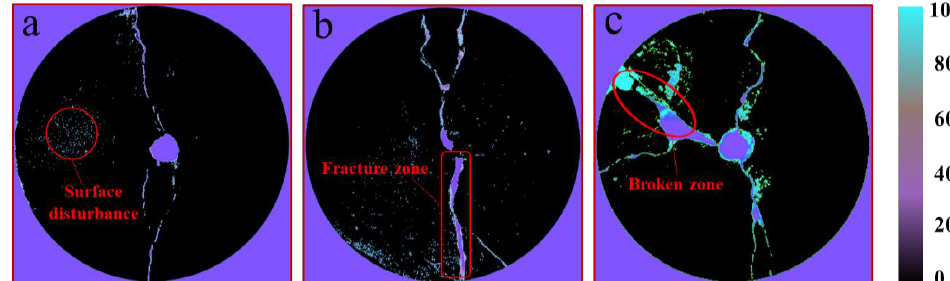
Figure 13. Characterization of damage degree of orifice surface of concrete specimen. ( a ) Characterization of presplitting rock of HEEA-I. ( b ) Characterization of presplitting rock of HEEA-II. ( c ) Characterization of presplitting rock of HEEA-III.